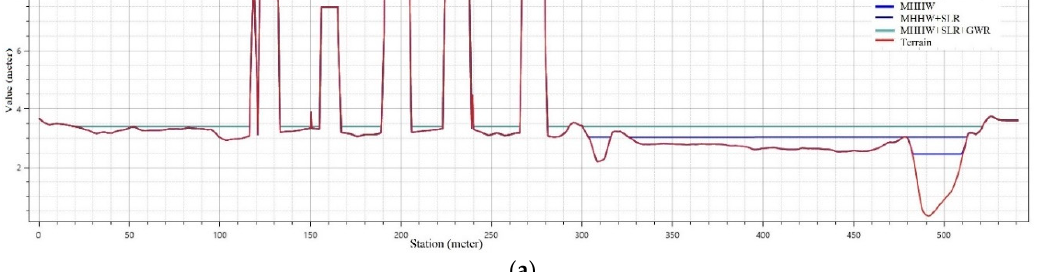
Figure 8. Blue area shows compound impacts of high tide (1.94 m), 1m SLR, groundwater inundation, and 2-year precipitation. Cross sections 1 and 2 are visualized in Figure 9.